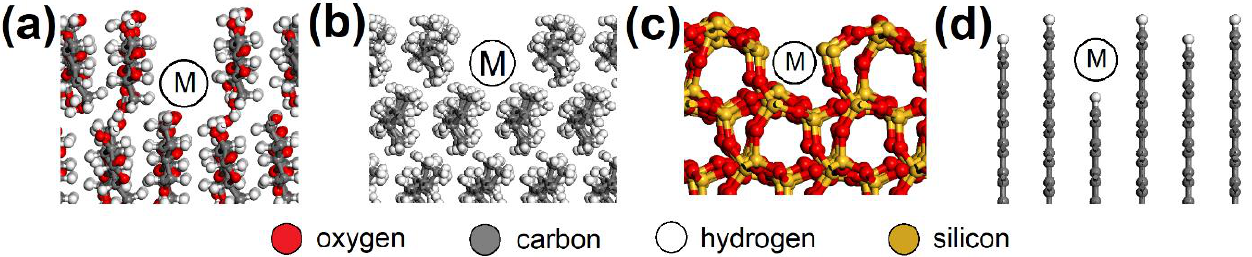
Figure 4. Molecular pores in the ( a ) CEL, ( b ) PP, ( c ) SiO 2 , and ( d ) AC surfaces with spots (M) where the NO or SO 2 molecule was placed. CEL — cellulose, PP — polypropylene, SiO 2 — silicon dioxide, AC — activated carbon.